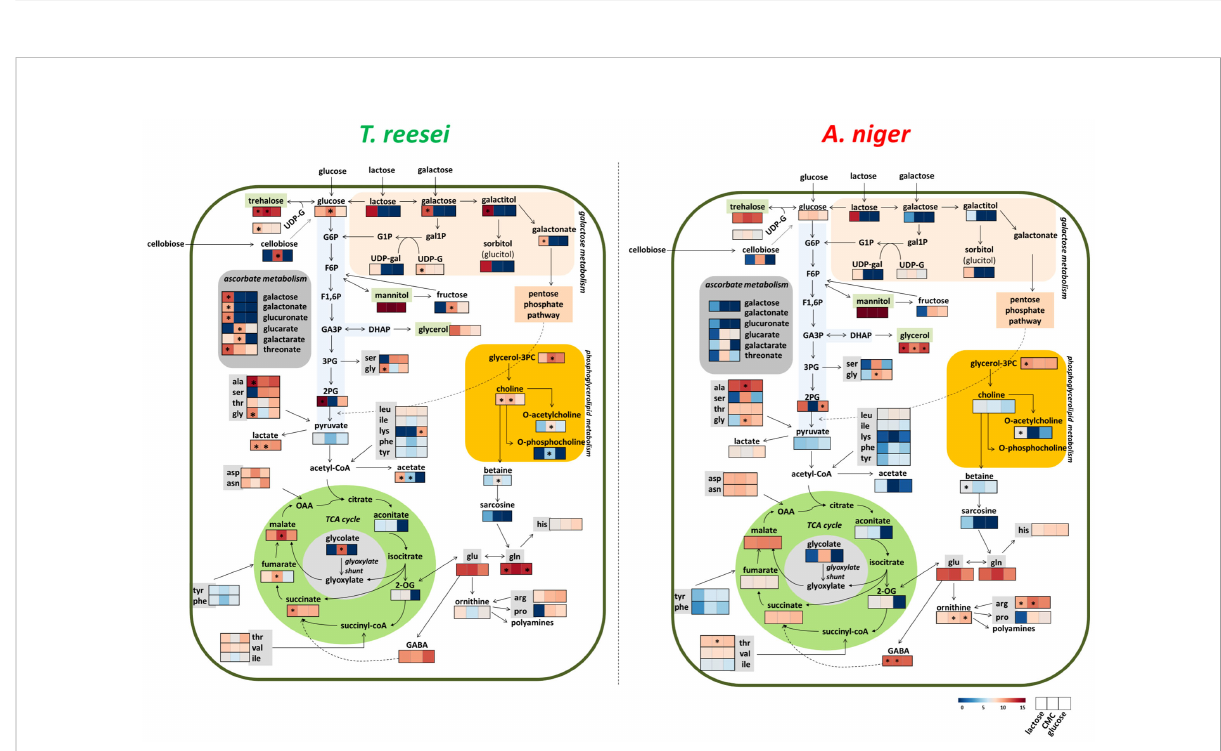
FIGURE 6 Overview of the metabolic alterations observed in T. reesei and A. niger grown on glucose, CMC, and lactose. The carbon sources in the broth media can be transported directly to the cell interior (glucose and lactose) or must be extracellularly hydrolyzed before entering the cells (CMC). For simplicity, some reactions involving intermediates that were not identi fi ed in our metabolomics analysis are not shown. Metabolites with signi fi cant differences for the same carbon source between the two fungi are highlighted (*). G1P, glucose 1-phosphate; G6P, glucose 6- phosphate; F6P, fructose 6-phosphate; F1,6P, 1,6-bisphosphate fructose; GA3P, glyceraldehyde 3-phosphate; DHAP, dihydroxyacetone phosphate; 3PG and 2PG, 3- and 2-phosphoglycerate; gal1P, galactose 1-phosphate; UDP-G, uridine diphosphate glucose; UDP-gal, uridine diphosphate galactose; TCA, tricarboxylic acid; 2-OG, 2-oxoglutarate; OAA, oxaloacetate; glycerol-3PC, glycerol 3-phosphoglycerate; ala, alanine; ser, serine; tre, threonine; gly, glycine; leu, leucine; ile, isoleucine; lys, lysine; phe, phenylalanine; tyr, tyrosine; asp, aspartate; asn, asparagine; arg, arginine; pro, proline; his, histidine; glu, glutamate; GABA,